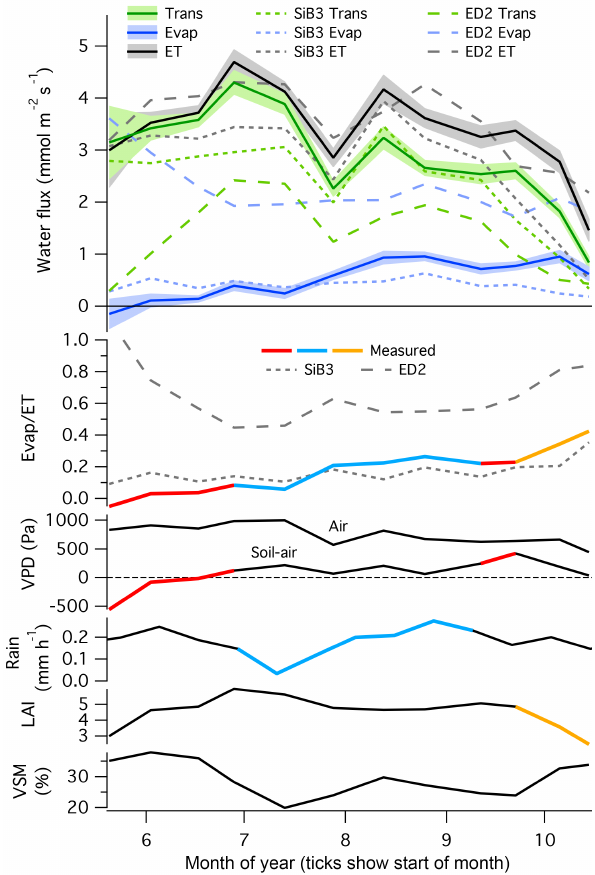
Figure 7. Composite seasonal cycles (including the years 2012 and 2013) of daytime evapotranspiration (ET), transpiration, and evap- oration, as estimated here and as predicted by the ED2 and SiB3 models, along with the ratio of evaporation (Evap) to ET, the at- mospheric vapor pressure deficit (VPD), the soil–atmosphere vapor pressure difference, rainfall, the leaf area index (LAI), and the vol- umetric soil moisture content between 0 and 30cm depth (VSM). Lines connect the mean values of each 2-week bin. Pale bands de- pict standard errors in the means as estimated from the variability within each bin. The soil–air vapor pressure difference is based on the assumption of saturated air at the soil surface and therefore re- flects the maximum possible difference. Color-coding in the lower panels highlights which environmental control is dominating the be- havior of the Evap / ET ratio. Model output was filtered to include only times when measurements were made.